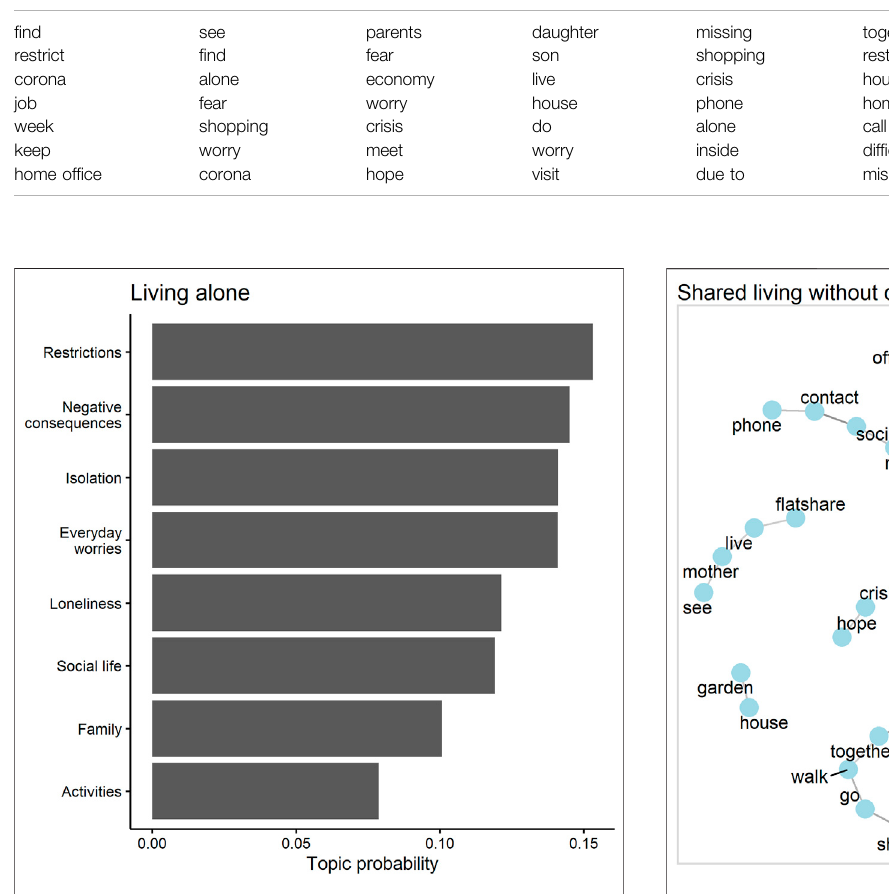
FIGURE 6 | Predicted topic probabilities for those living alone. FIGURE 7 | Word network for shared living without children